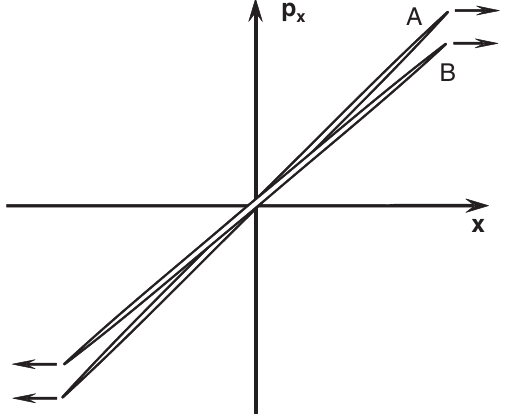
FIG. 12. Schematic distortion of the transverse phase space due to the time-dependent focusing of the rf field. Only two ellipses, A and B , indicating a slice in the head and in the tail of the bunch are shown. The other slices, which are filling the area between the head and the tail slice, are omitted for the sake of clarity. Only if slice A shears faster than slice B can the fan